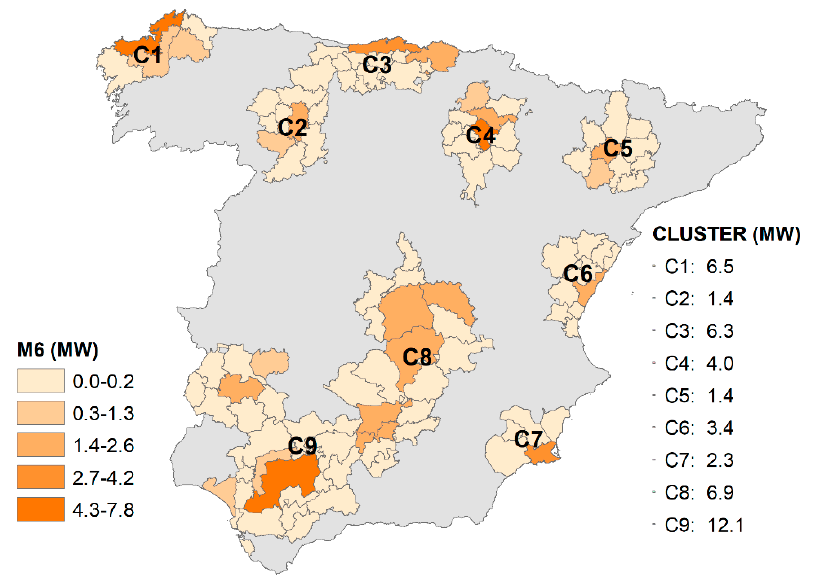
Figure 6. Geographical distribution of the power potential and clusters’ power for mixture M6.